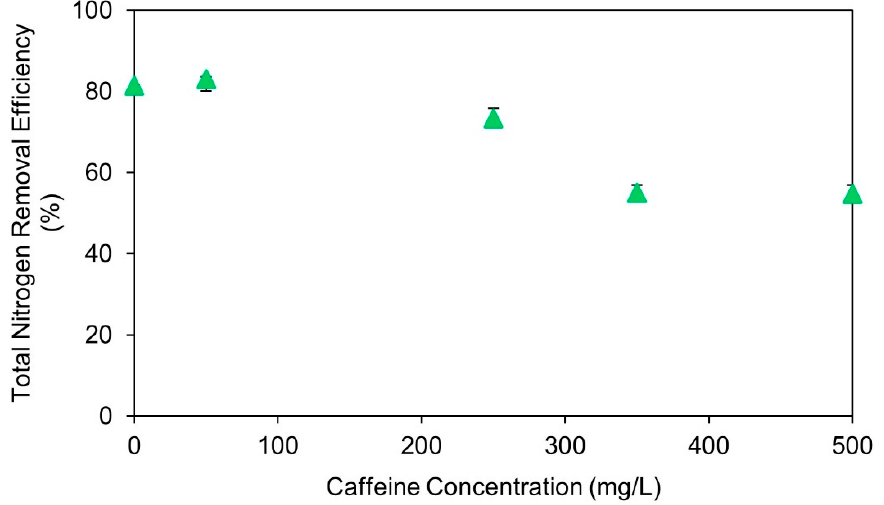
Figure 1. Percentage of total nitrogen removal efficiency at the end of 7 h as a function caffeine dosing concentration (0, 50, 250, 350, and 500 mg/L).